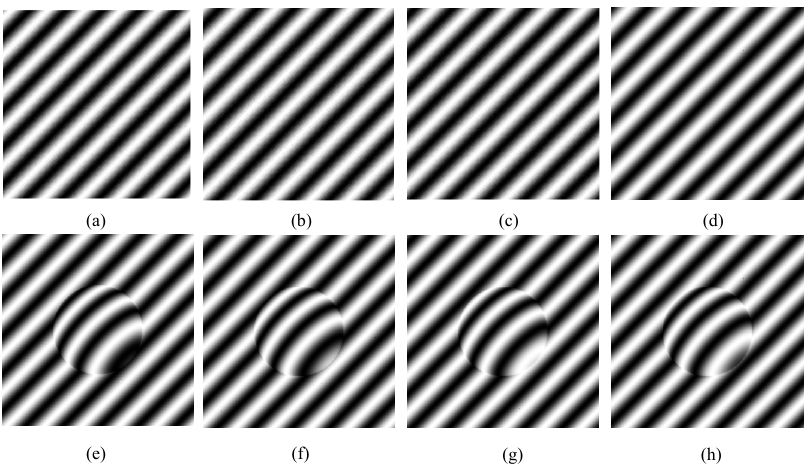
Figure 7. The decrypted images of eight fringe images. ( a – d ) The decrypted images of four original fringe images; ( e – h ) the decrypted images of four deformed fringe images.